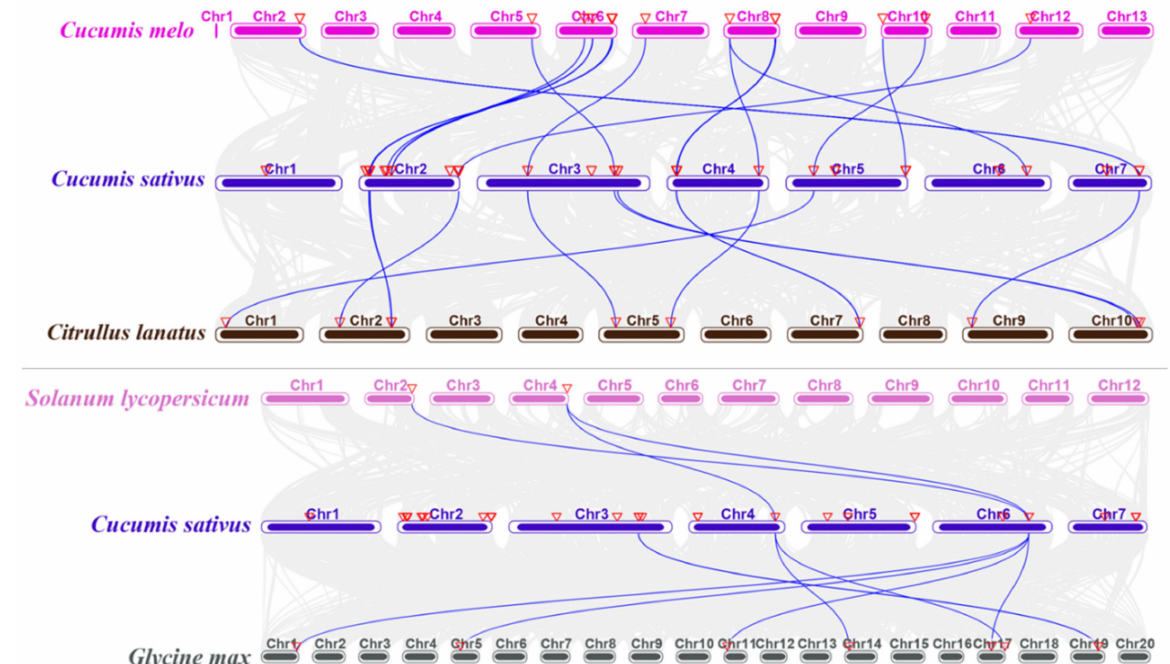
Figure 4. Synteny of the CNL genes among cucumber and other species. Gray lines in the background represent collinear blocks in cucumber plants and other genomes. The collinear gene pairs with CNL genes between different species were highlighted by the blue lines. Red inverted triangle indicated the locations of the CNL genes. Cucumber ( C. sativus L.), melon ( Cucumis melo L.), watermelon